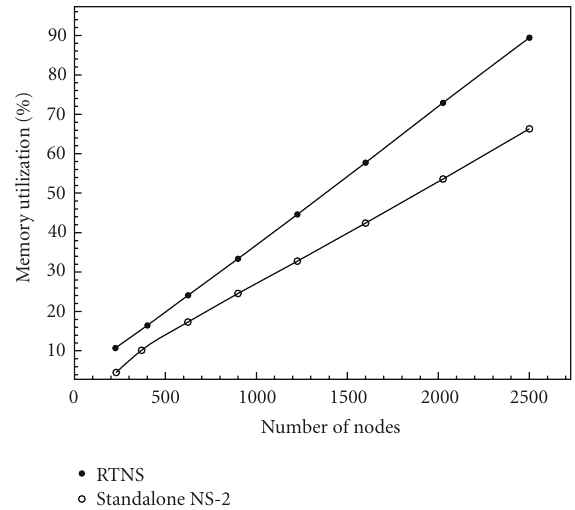
Figure 13: Execution time as a function of the total number of nodes for standalone NS-2 and RTNS.